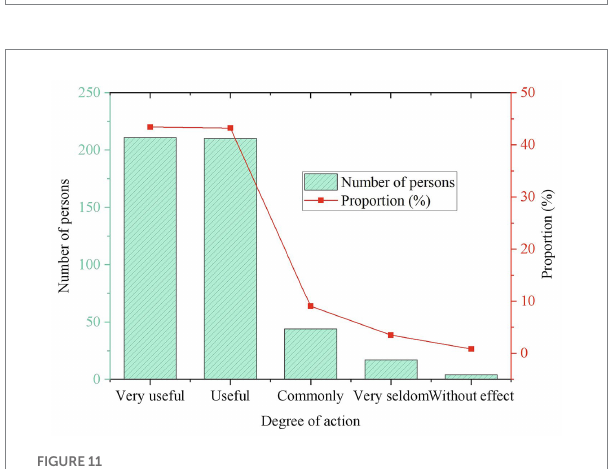
FIGURE 11 Whether the process of participation in folk art has a role in the development of mental